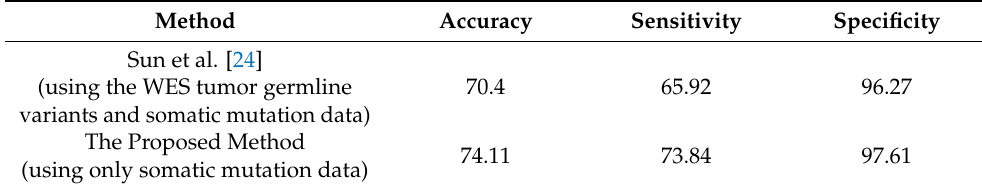
Table 4. Results of the proposed method and those of Sun et al.